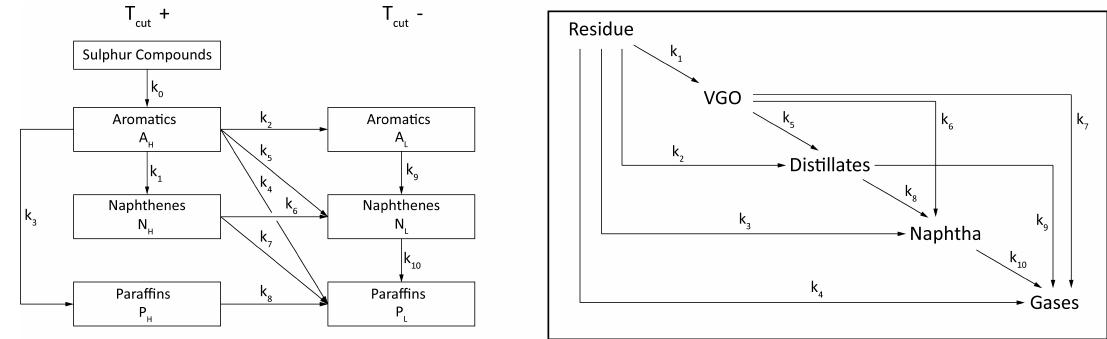
Figure 36. Detailed lumped kinetic reaction schemes for hydrocracking, proposed by Krishna ( left ) and Sanchez ( right ). Figures adapted from refs.